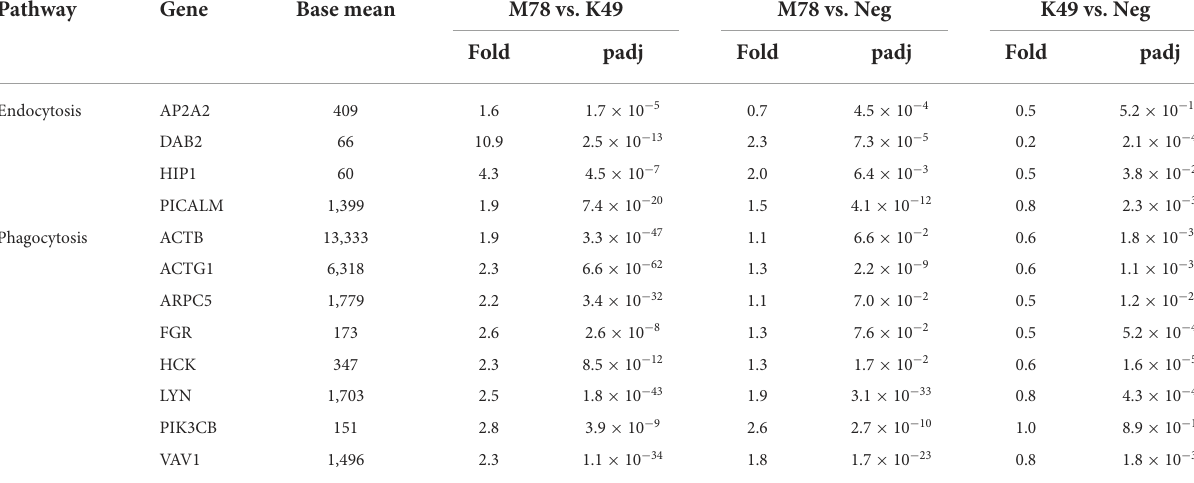
*ND,notdetermined. TABLE 7 Differential expression of genes involved in endocytosis and phagocytosis in PBMCs infected with ASFV strains K49 or M78 (FDR ≤ 0.05). Pathway